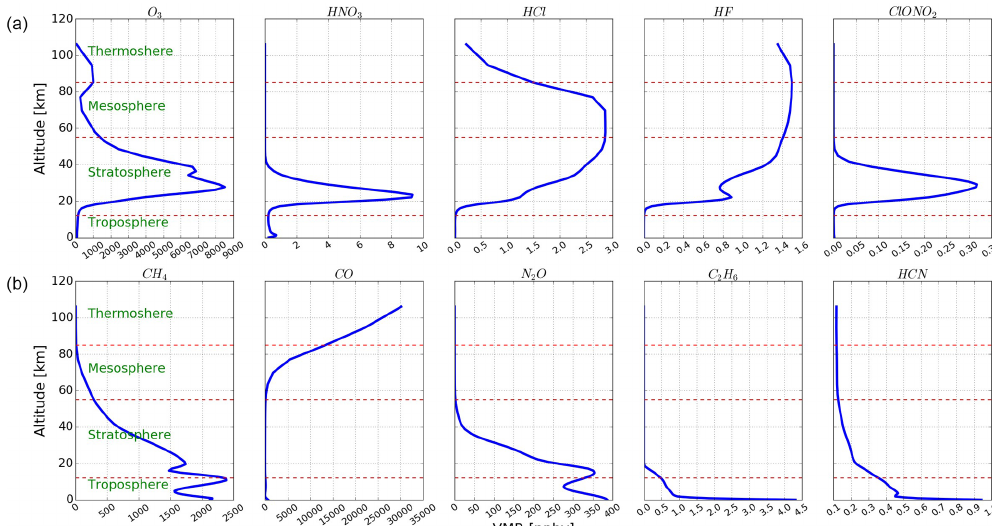
Figure 3. Typical profiles of 10 NDACC gases. The panels in (b) show the five tropospheric gases, i.e. CH 4 , CO, N 2 O, C 2 H 6 , and HCN. The panels in (a) show the five stratospheric gases, i.e. O 3 , HNO 3 , HCl, HF, and ClONO 2 . Although the CO concentration above 60km is much higher than that in the troposphere, it is regarded as tropospheric gas because it is an anthropologic pollution gas and shows large variation in the troposphere.